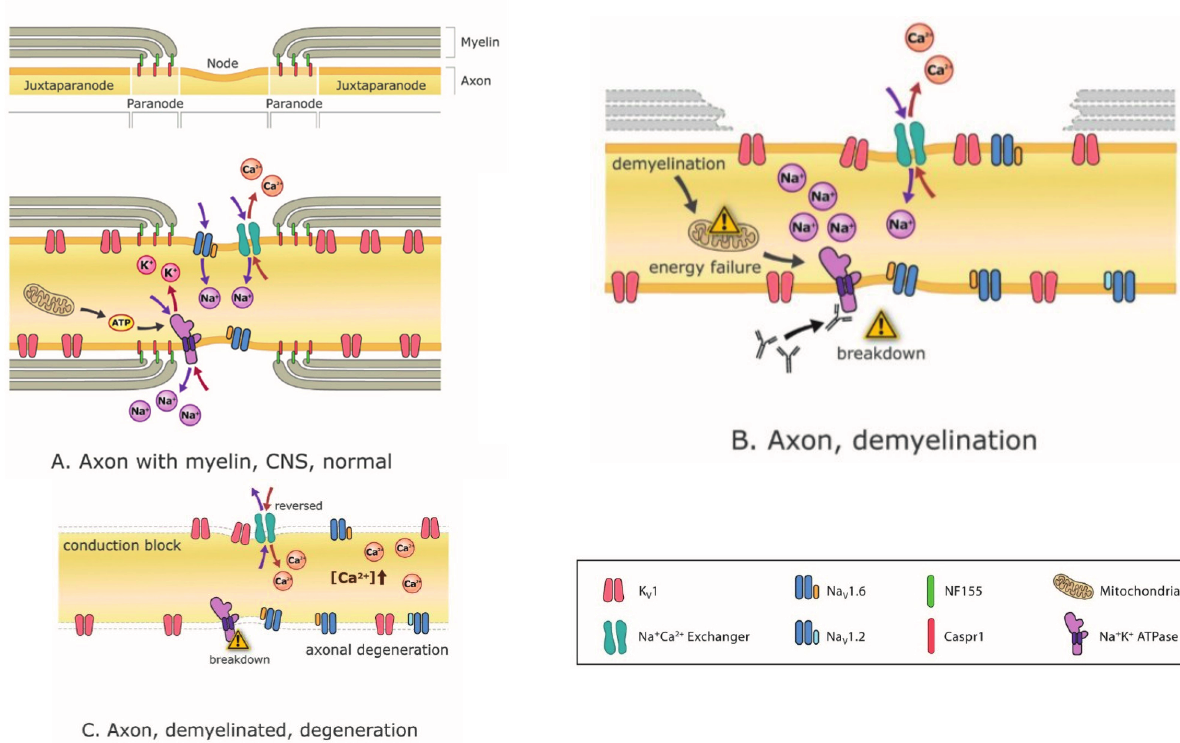
Figure 3. Mechanisms of demyelination-related Neurodegeneration. Demyelination